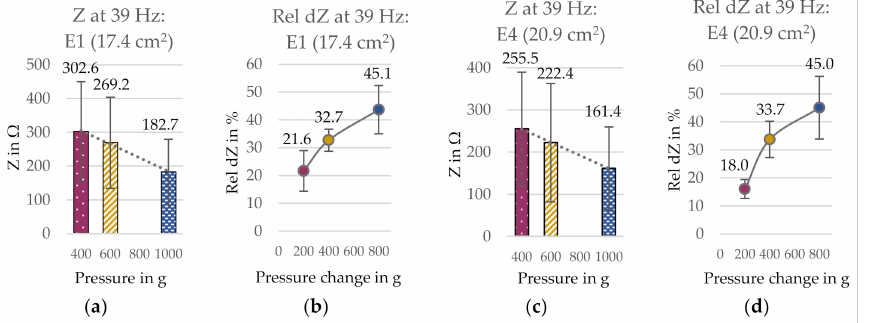
Figure 14. ( a ) Contact impedance Z and ( b ) relative impedance change rel dZ at 39 Hz for electrode E1 (smooth surface, circle, low yarn density). ( c ) Contact impedance Z and ( d ) relative impedance change rel dZ for electrode E4 (uneven surface). SD pictured as error